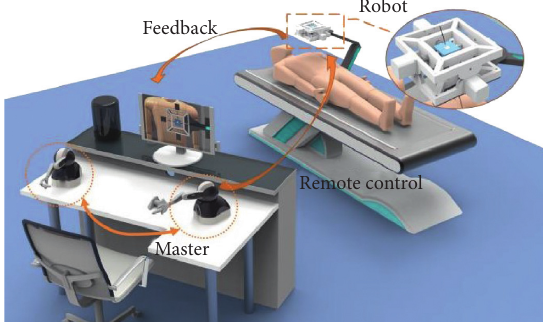
Figure 1: Surgical assistant robot remote operating